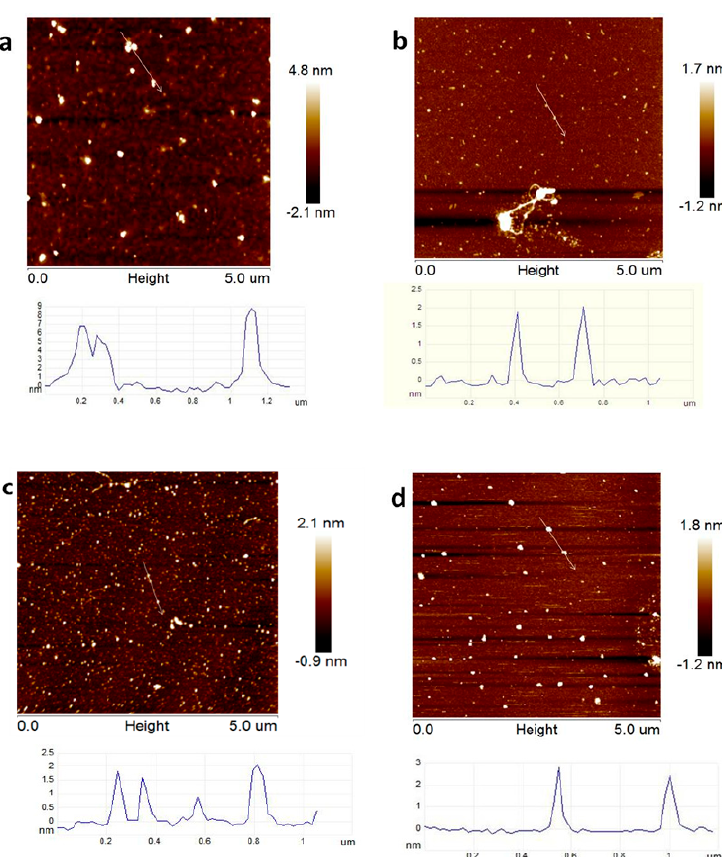
Figure 2. AFM image of KGM treated with di ff erent ultrasonic time (image size = 5 × 5 µ m); ( a ) non–sonication, ( b ) 15 min, ( c ) 30 min, ( d ) 60 min.